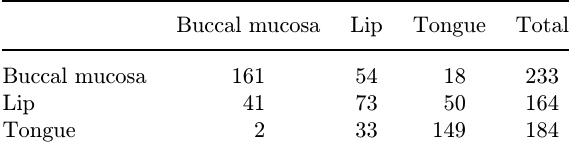
Table 2. PC-LDA for identifying anatomical di®erences at buccal mucosa, lip and tongue subsites in oral cavity of healthy subjects.